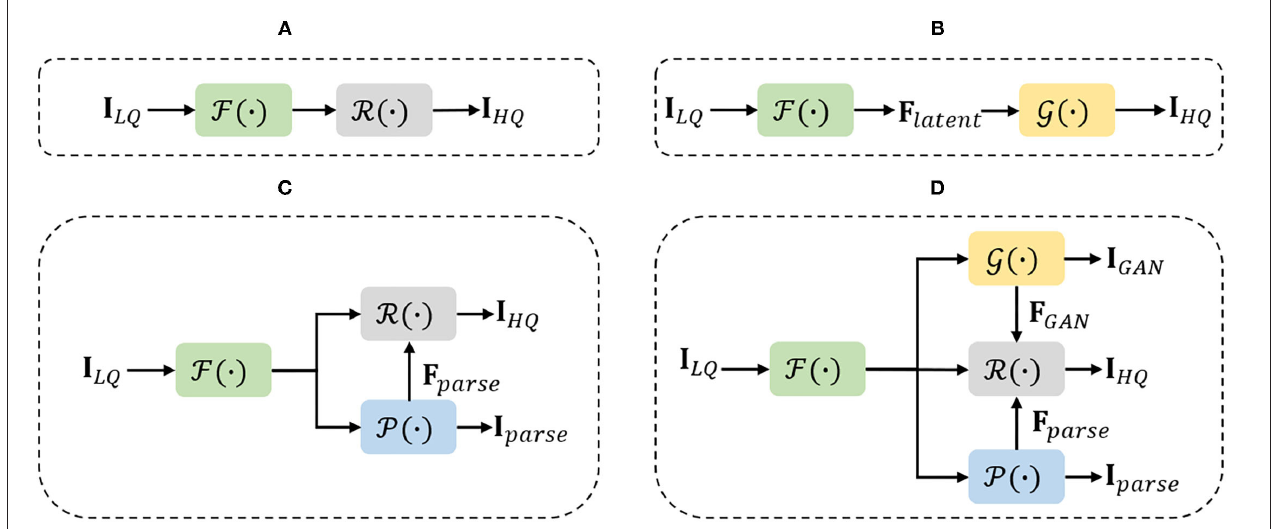
FIGURE 1 | Diagrams of the main ideas of four different paradigms applying for blind face restoration (BFR). In the figures, F ( extraction, generative adversarial network (GAN) prior production, Parsing map prior production, and the restoration network, respectively. (A) Framework of basic CNN-based methods. (B) Framework of GAN prior embedded network. (C) Framework of parsing map guided network. (D) Framework of our multi-prior collaboration